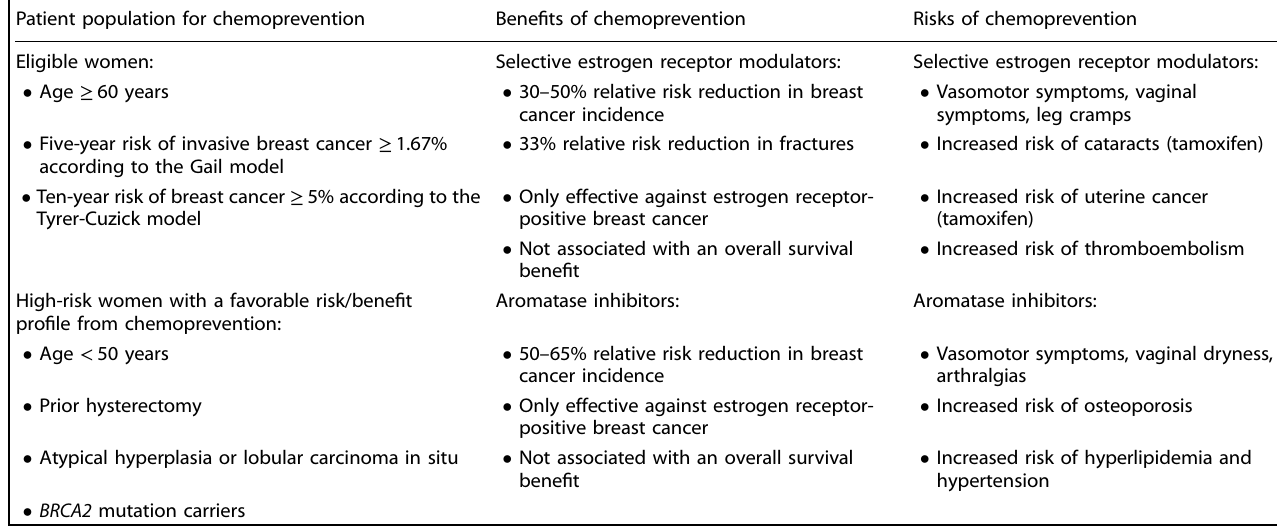
Table 2. Summary of the high-risk women eligible for chemoprevention and the risks and bene fi ts of selective estrogen receptor modulators ( SERMs ) and aromatase inhibitors ( AIs ) for primary prevention Patient population for chemoprevention Bene fi ts of chemoprevention Risks of